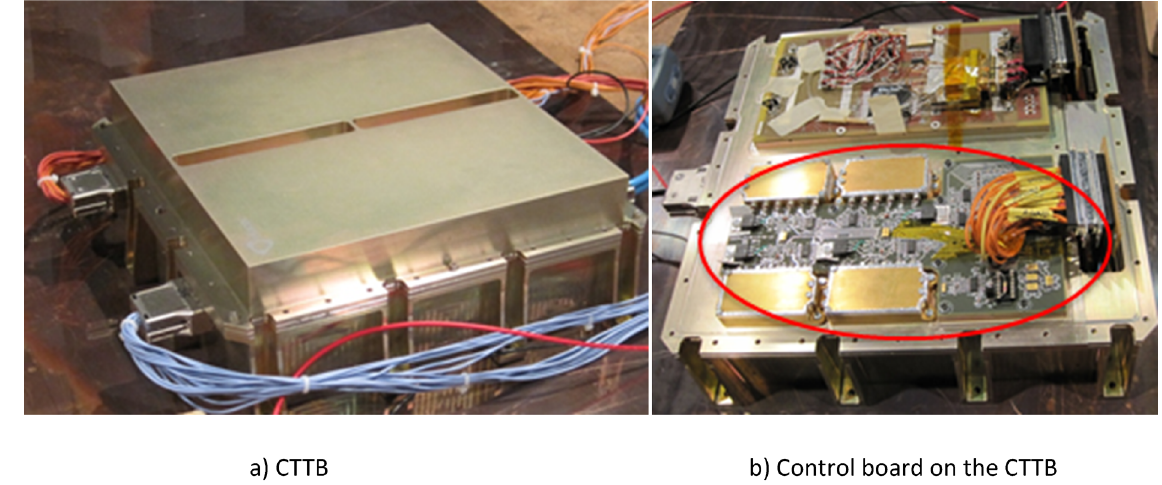
Figure 2. ( a ) CTTB, ( b ) Control board on the CTTB.